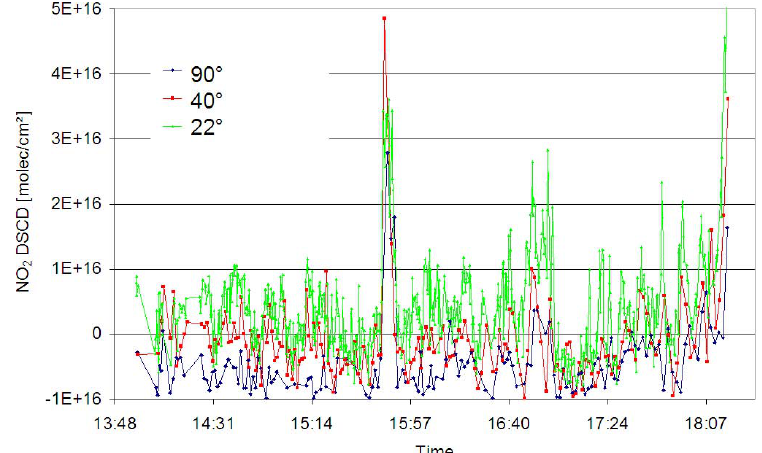
Fig. 2. NO 2 DSCDs analysed from the spectra measured along the route between Brussels and Heidelberg. Results for all three elevation angles are shown. Especially for the higher elevation angles, also many negative values are found indicating that the NO 2 -absorption of the Fraunhofer reference spectrum is not negligible. As expected higher DSCDs are obtained for smaller elevation angles.